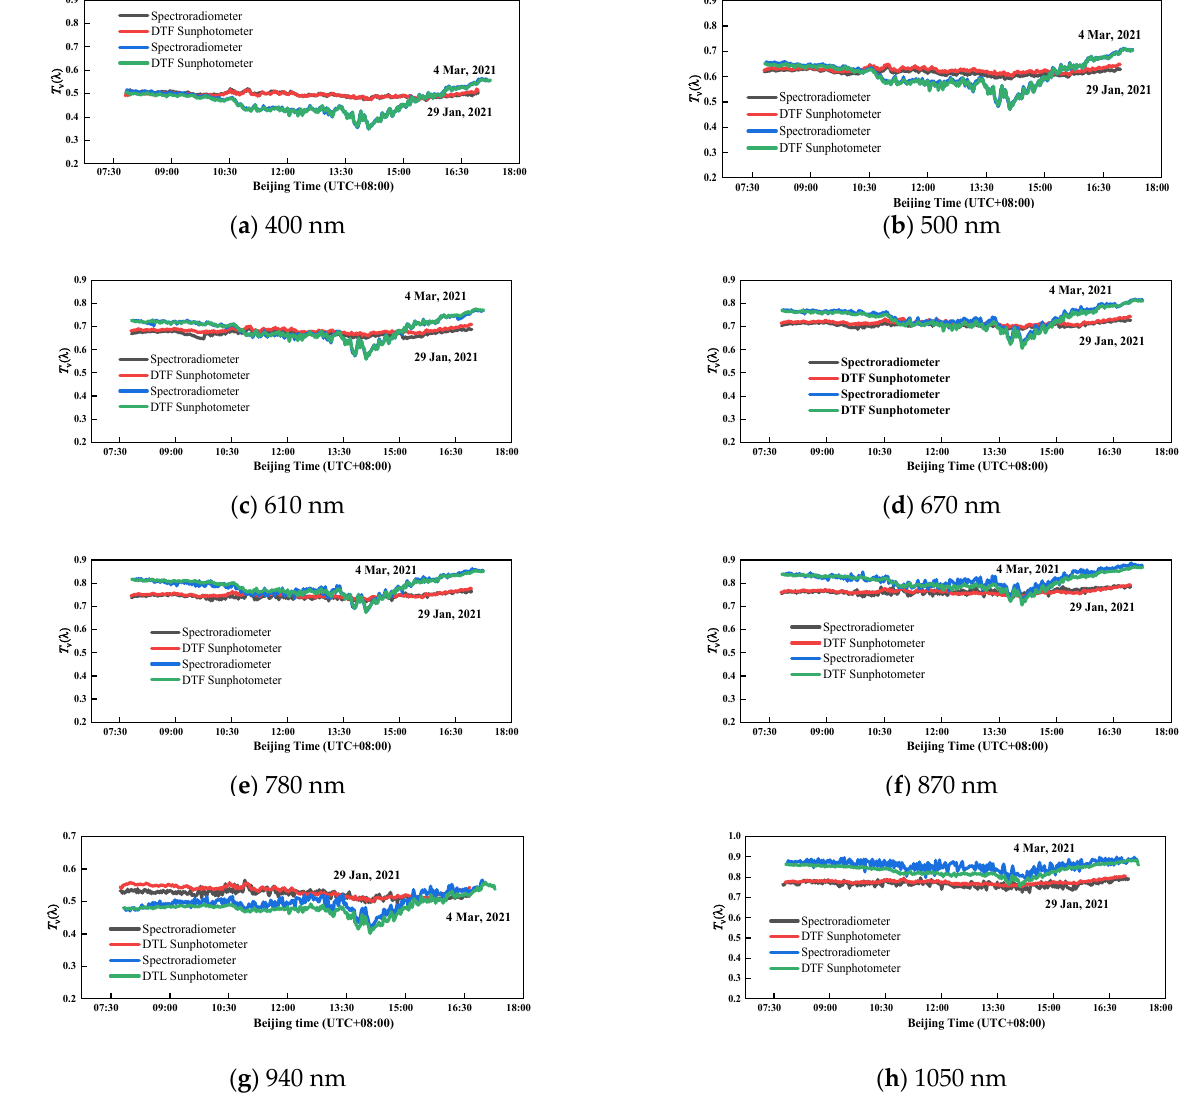
Figure 10. Comparison of atmospheric transmittance between spectroradiometer and DTF sun-photometer in the eight selected